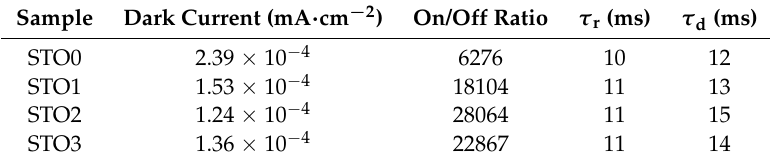
Table 2. Dark current, on/off ratio, τ r and τ d of UVPDs based on STO0, STO1, STO2, STO3. Sample